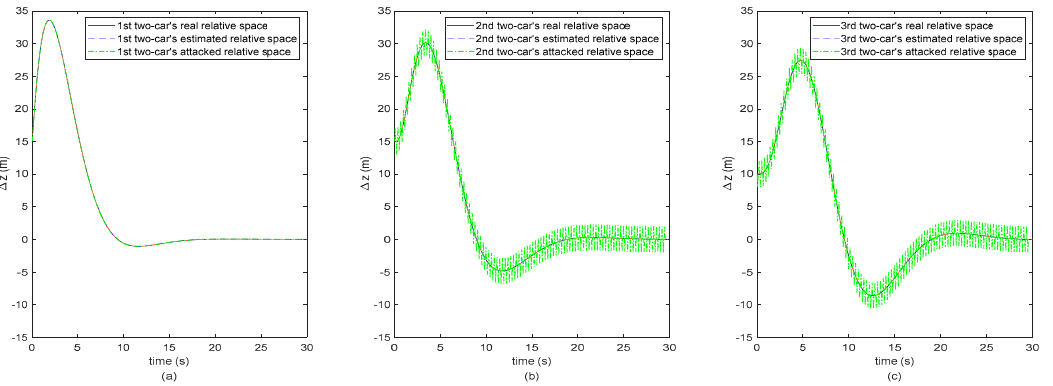
Figure 3. The three 2 ‐ cars’ spacing. ( a ) The 1st two ‐ car, ( b ) The 2nd two ‐ car, ( c ) The 3rd two ‐ car.